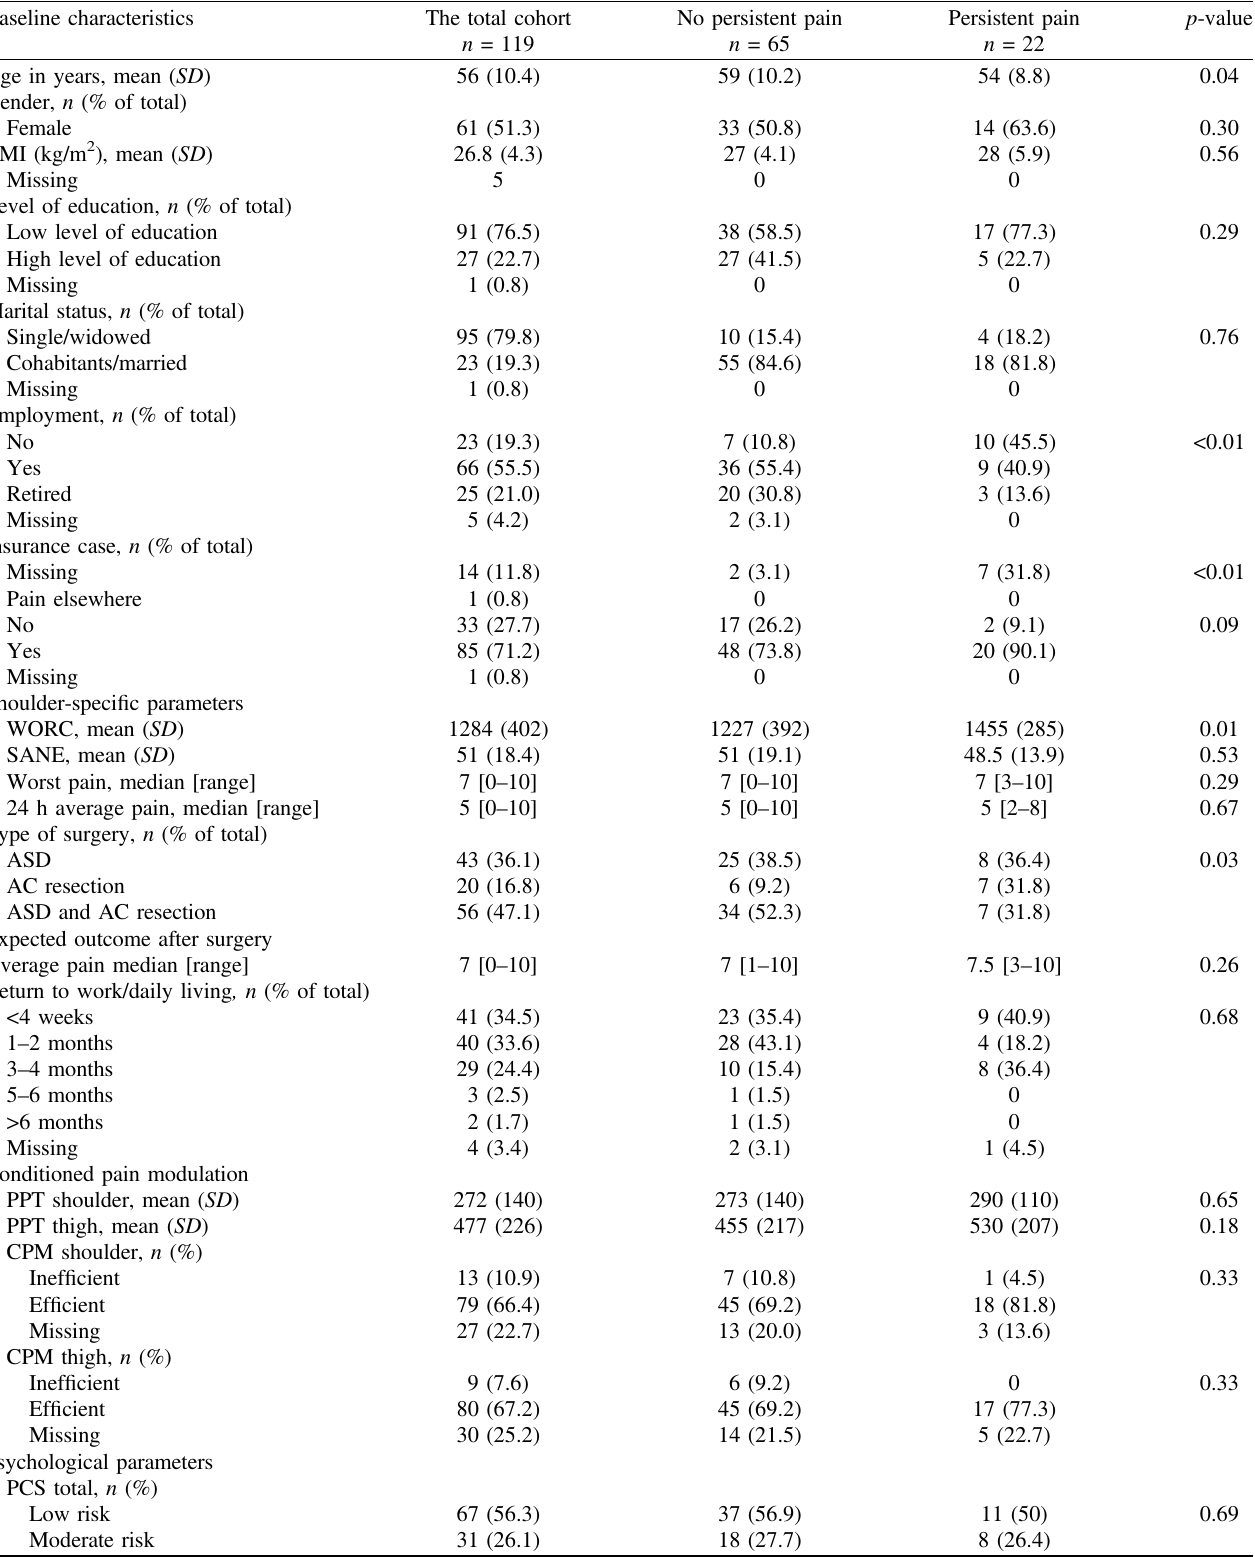
Table 1. Patient